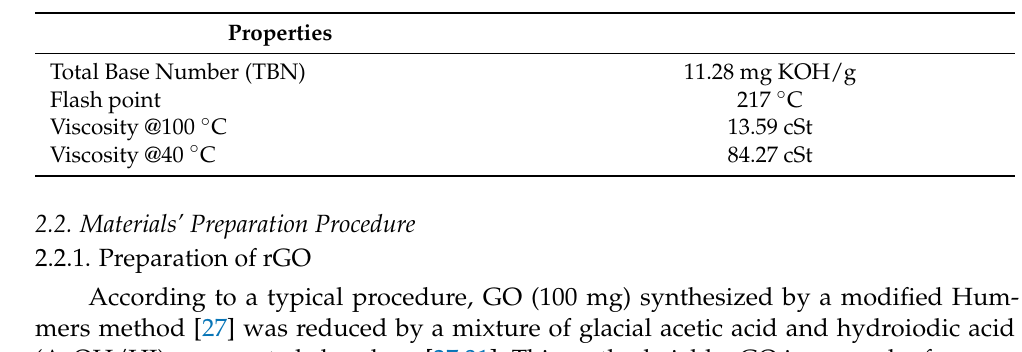
Table 1. The properties of 5W-40 synthetic engine oil.